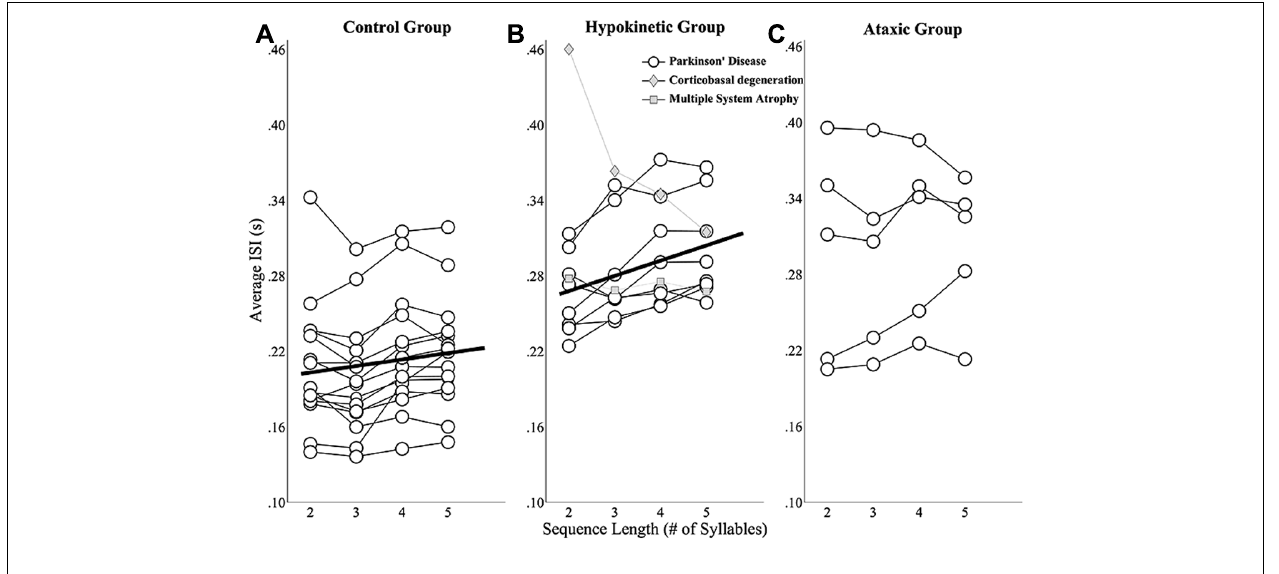
displayed in the plots for these groups. Data from the hypokinetic speaker with MSA (gray diamonds) and the speaker with CBD (gray squares) are indicated separately in the plot for the hypokinetic speakers (B) . No significant effect of sequence length on the average ISIs of the ataxic speakers was